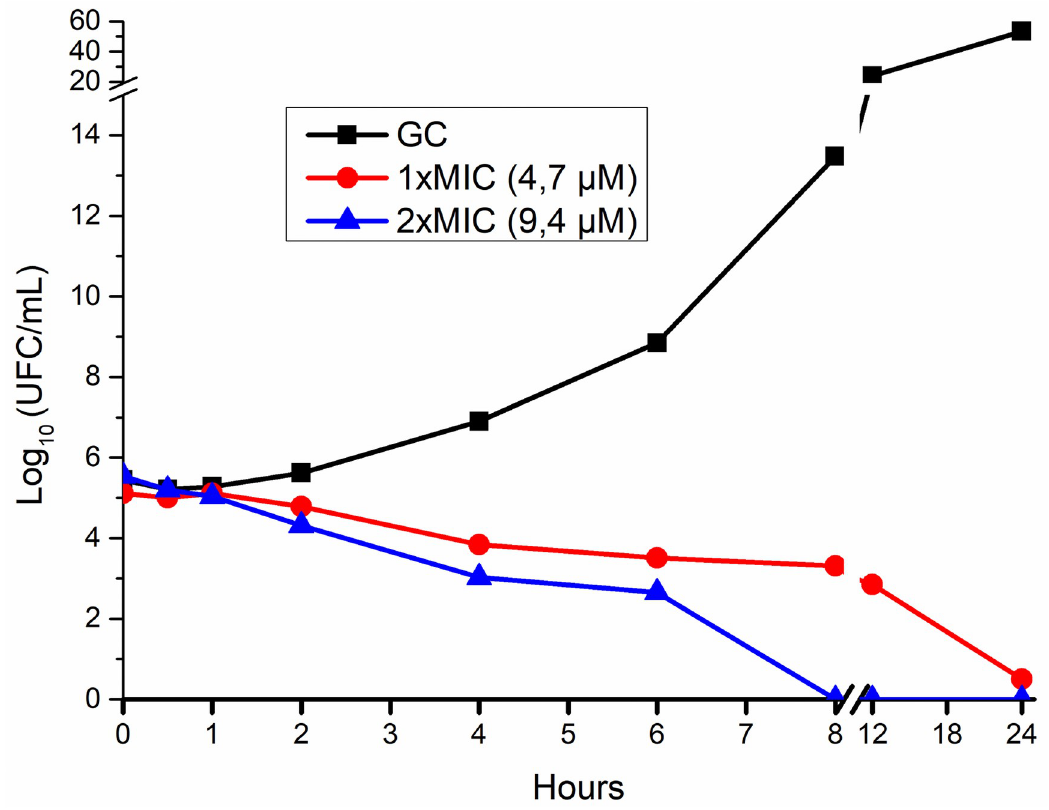
Fig 4. Time-kill kinetics of E . coli O157: H7 exposed to Ib-M1 peptide. Time-kill kinetics of E . coli O157: H7 (ATCC 43888) within 24 hours of exposure to Ib-M1. Each concentration was evaluated in quadruplicate. The results are expressed in terms of the arithmetic average ± standard deviation. (The data that do not show error bars correspond to those in which standard deviation is too small to be seen). GC: Growth